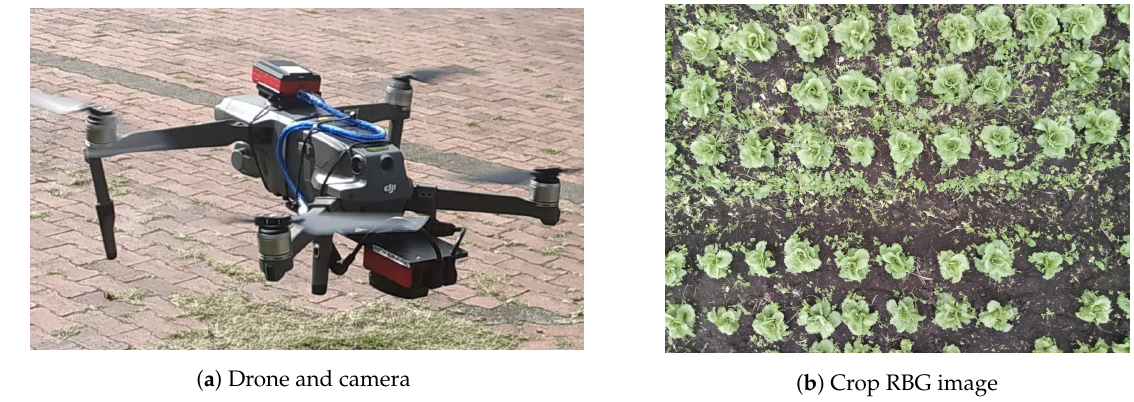
Figure 1. ( a ) Mavic Pro with the Parrot Sequoia multispectral camera. ( b ) Image taken by the RGB sensor of the Parrot Sequoia camera during the flight.